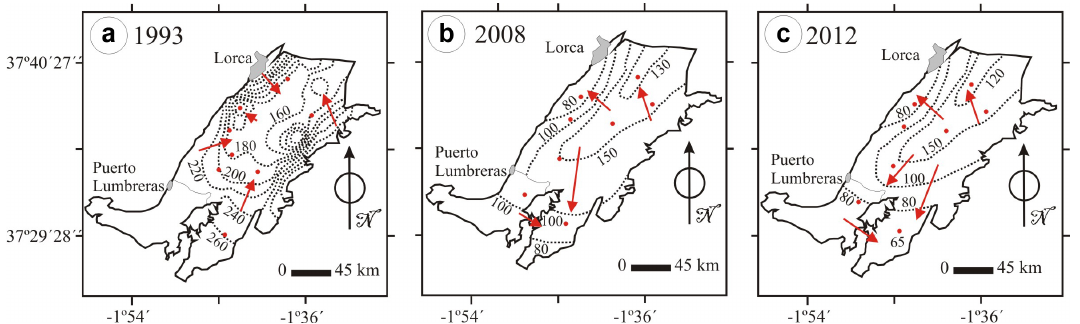
Figure 11. Temporal evolution in the Alto Guadalentín aquifer piezometry. (a) 1993 piezometric contour lines with overexploitation signs. (b) Aquifer in 2008 with inverse groundwater flow. (c) Drop in groundwater surface in 2012 (source: modified from IGME, 2009 and CHS, 2014).